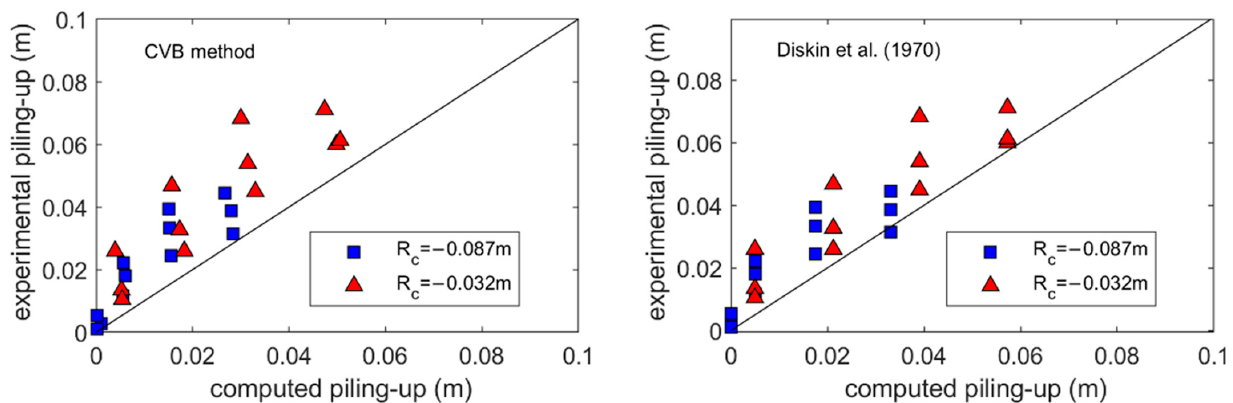
Figure 16. Comparison of experimental data with the literature formula: CVB method [19,22] in the left panel; [24] in the right panel.